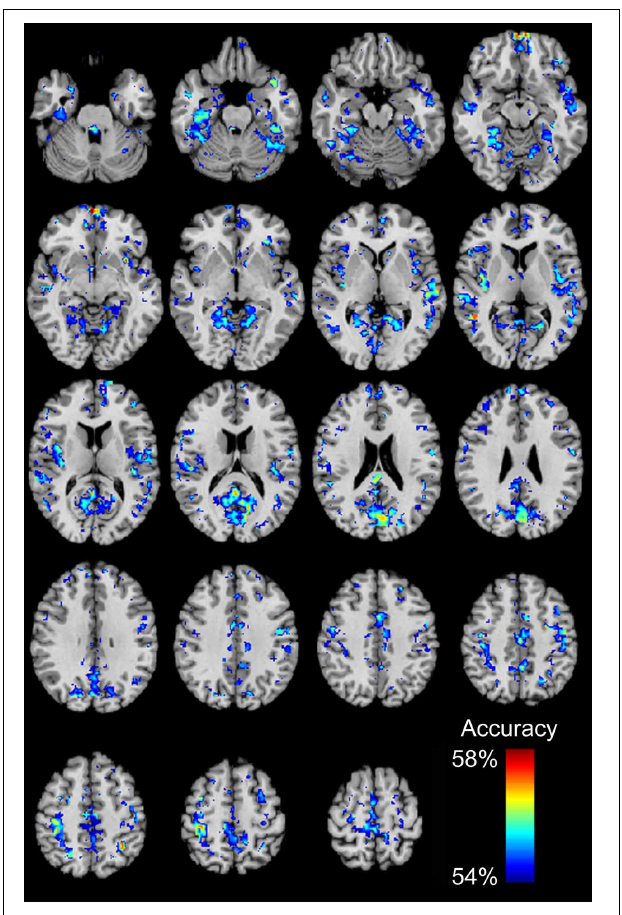
FIGURE 5 | Total accuracy for 7266 brain regions. Accuracy was determined for each of the 7266 brain regions independently by only taking into account the 7265 connections in which a given region was involved (no p -value threshold, all connections used). The minimum accuracy displayed for a single region is 53.95%, which was the false discovery rate corrected percentage for 7266 regions and a binomial cumulative